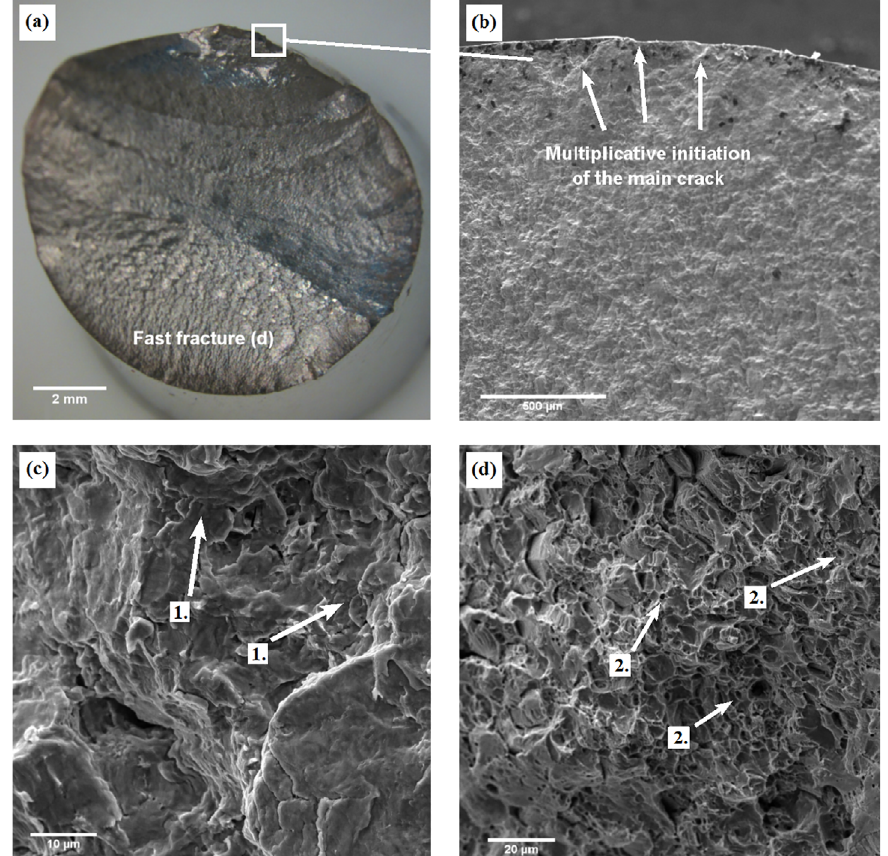
Figure 10 . Inconel 625 fracture surface after failure in 23432 cycles under maximum stress of 586 MPa: (a) appearance of the surface fracture, (b) nucleation region of the microscopic crack, (c) failure mode in the stable crack growth region, (d) failure mode in the fast fracture